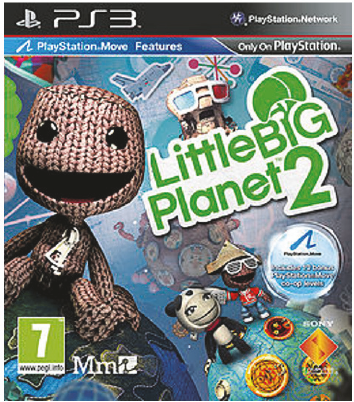
Figure 3: Selected game, LittleBigPlanet2 (Sony Computer Enter- tainment Europe,